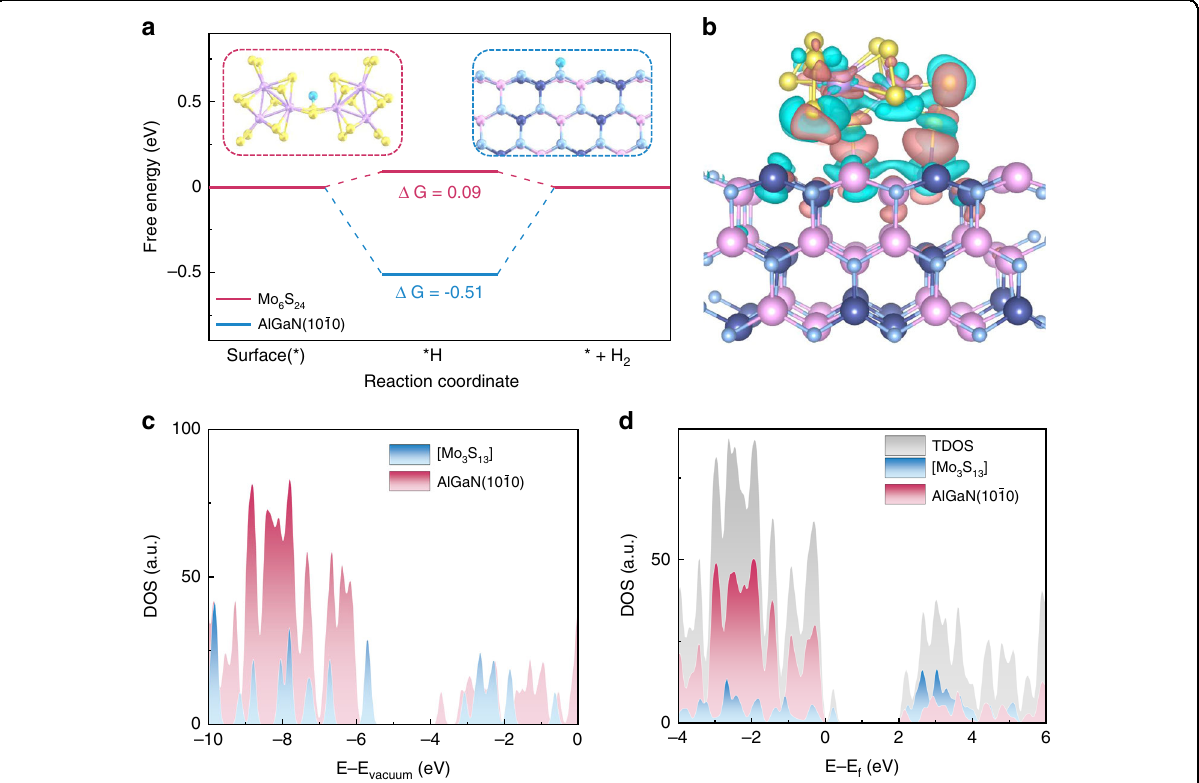
Fig. 5 DFT calculations. a Free energy diagram for HER on Mo 6 S 24 (red line) and AlGaN (1010) (blue line). Inner fi gures show the con fi gurations of *H on the Mo 6 S 24 (red box) and AlGaN (1010) (blue box). The balls in yellow, purple, sky blue, light blue, navy and pink represent S, Mo, H, N, Al and Ga atoms, respectively. b Electron density difference plot of the Mo 3 S 13 /AlGaN(1010), the deletion and accumulation of electrons are represented by the blue and red regions, respectively. c The density of states of the clean AlGaN(1010), clean Mo 3 S 13 and d total density of states (TDOS) of Mo 3 S 13 / AlGaN(1010) and the projected density of states of Mo 3 S 13 and AlGaN (1010) in Mo 3 S 13 /AlGaN (1010). The energy level is relative to vacuum level in c and Fermi level in